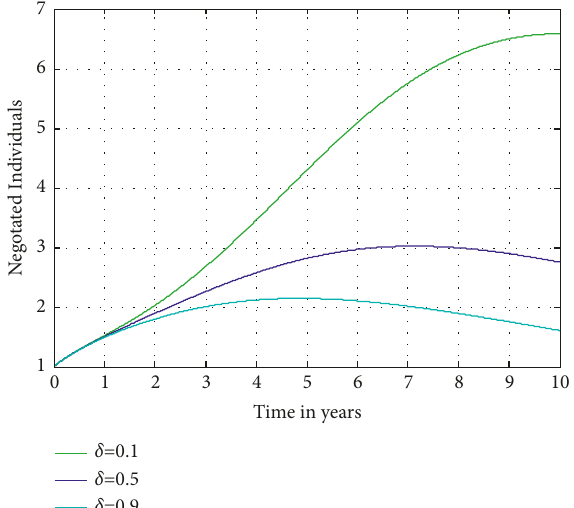
Figure 6: Effect of the reconciled rate δ on the negotiated indi- viduals. H.